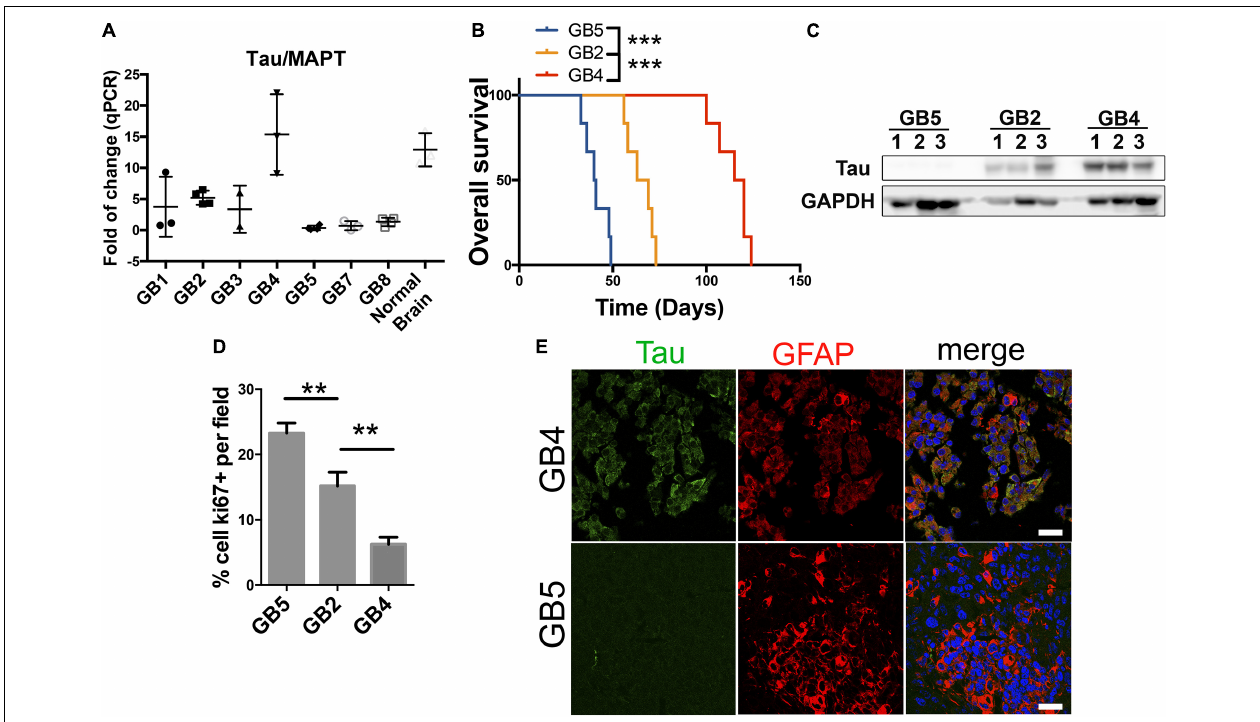
FIGURE 2 | Tau/MAPT expression correlates with less aggressive glioblastomas of PDXs. (A) Quantification of Tau/MAPT mRNA expression levels by qPCR in 7 different glioblastomas derived from patients implanted in flanks of nude mice. Normal human brain tissue was used as control. (B) Kaplan meier curve of 3 PDXs with different Tau expression levels implanted in the brain of nude mice ( n = 6 for each group). (C) Tau expression levels analysis by western blot of tissue extracts of the experiment described in B using GAPDH as loading control. (D) Quantification of Ki67 cells percentage by immunohistochemistry (IHC) of PDXs tissue of samples described in (B) . (E) Tau and GFAP expression analysis by IHC in tumor tissue of samples described in (B) , showing Tau expression in green and GFAP in red, of the PDXs with high and low expression of Tau. ∗∗∗ p value < 0.0001, ∗∗ p value < 0.01. Scale bar 25 µ